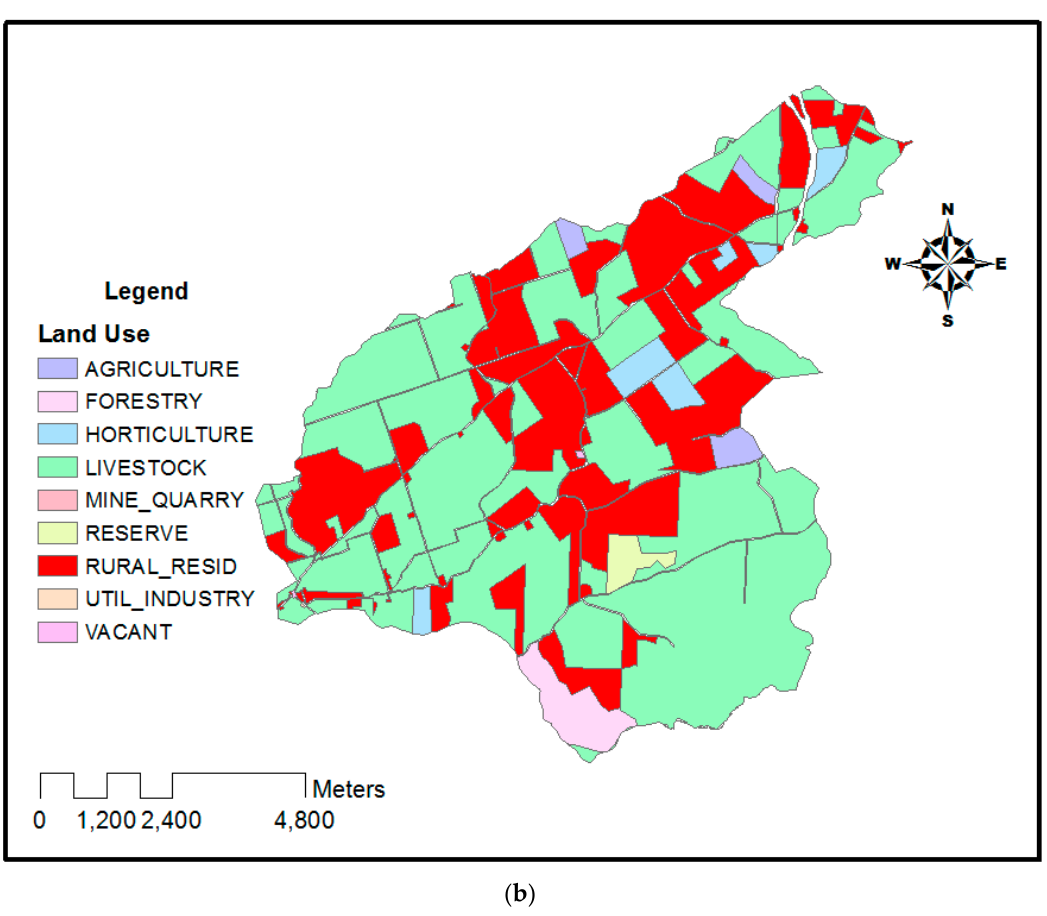
Figure 1. ( a ) Myponga upstream (U/S) catchment with meteorological stations; ( b ) Major land uses in the Myponga upstream catchment.